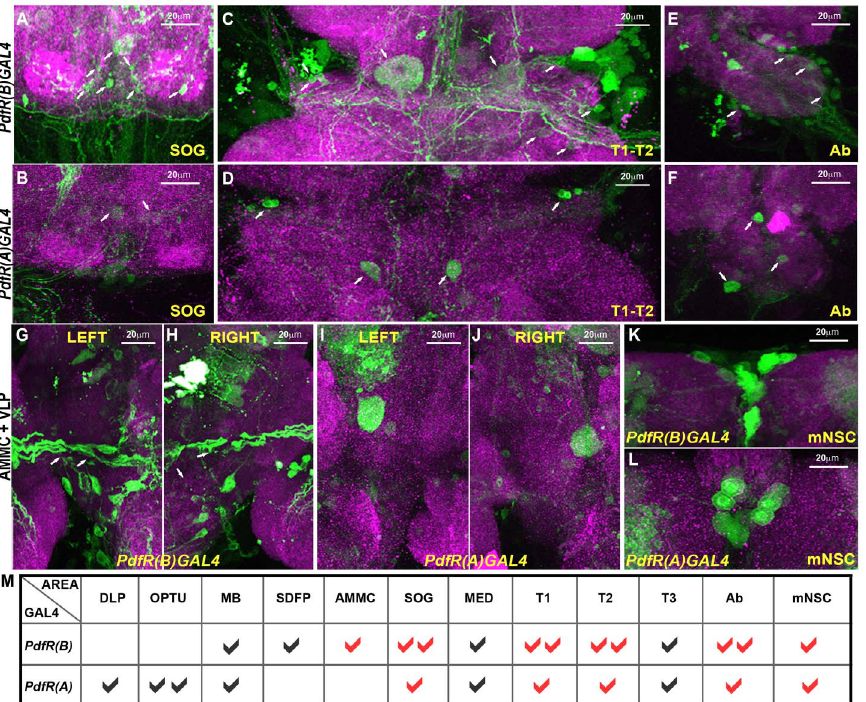
Figure 8. Differential expression of PdfRGAL4 strains in neurons of the adult AMMC, SOG and thoracic ganglia. Expression patterns of the indicated PdfRGAL4 strains in the sub-esophageal ganglion, SOG (A, B), thoracic region 1 and 2, T1–T2 (C, D) and abdominal regions, Ab (E, F) are shown. A schematic of these regions of the Drosophila central nervous system is given in Figure S4. GFP expression is reduced in the SOG, TI, T2 and abdominal region in PdfR(A)GAL4 . Expression of GFP in left (G, I) and right (H, J) ventrolateral protocerebrum (VLP) and antennal mechanosensory and motor complex (AMMC) using PdfR(B)GAL4 (G, H) and PdfR(A)GAL4 (I, J) driver is shown. White arrows indicate neuron/cluster of neurons which are positive for GFP expression. GFP expression is reduced in the AMMC when using PdfR(A)GAL4 driver as compared to PdfR(B)GAL4 . Expression pattern of GFP in medial neurosecretory region, mNSC (K, L) using PdfR(B)GAL4 (K) and PdfR(A)GAL4 (L) drivers are shown. GFP expression is similar in medial neurosecretory region in PdfR(B)GAL4 and PdfR(A)GAL4 . M) Summary table of expression patterns of PdfR(B)GAL4 and PdfR(A)GAL4 . The areas that were examined: DLP: dorsolateral protocerebrum, OPTU: optic tubercle, MB: mushroom body, SDFP: superior dorsofrontal protocerebrum, MED: medulla. Ticks indicate the presence of expression. Two ticks indicate high expression. Red ticks represent areas that have been shown in high magnification. For each genotype, 5 brain samples were analyzed.